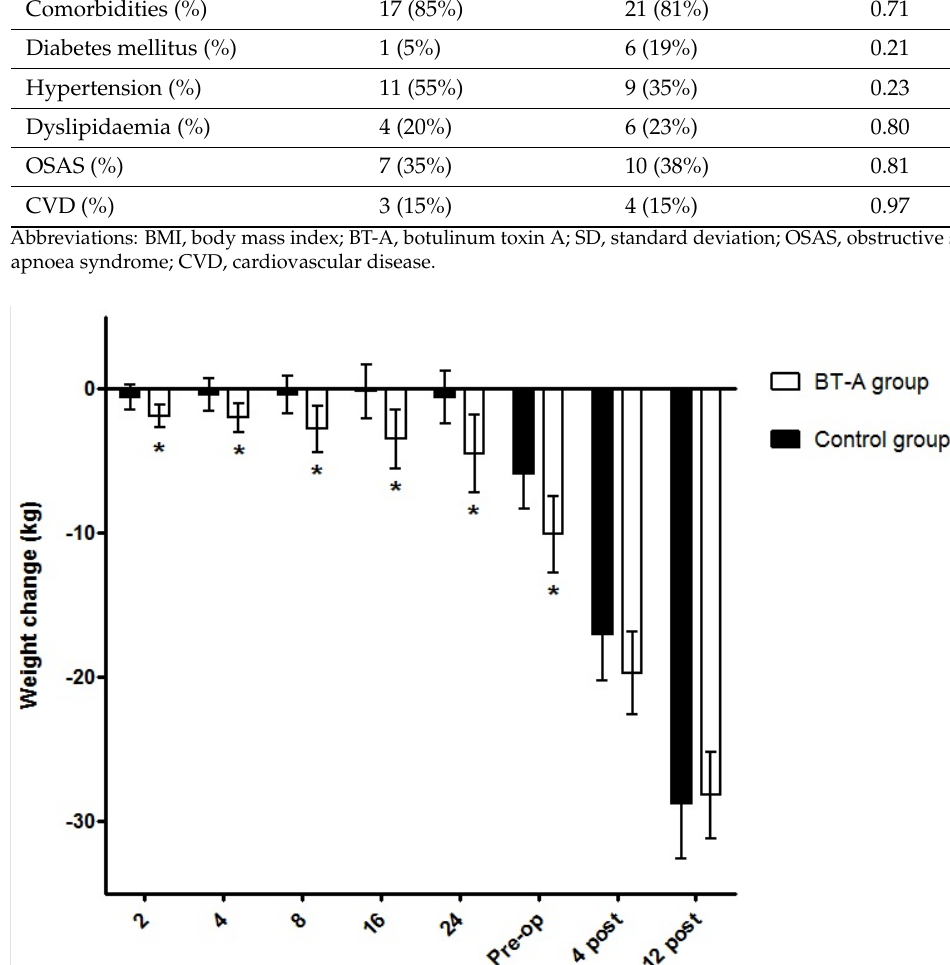
The results of weight loss percentage after stratifying by BMI are shown in Figure 3.